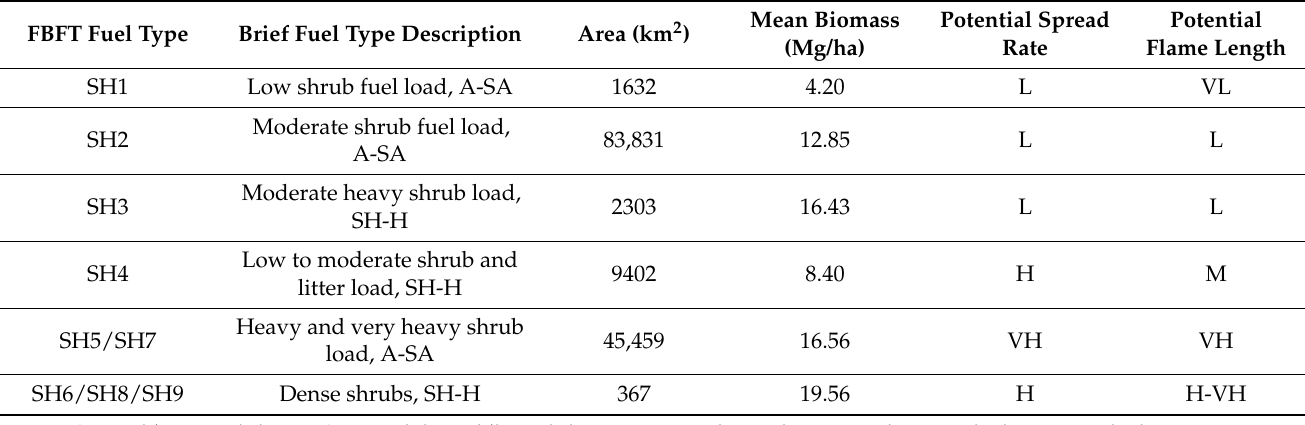
Table 3. Characterization and parameterization of the FBFT-adapted shrub fuel types. The values refer to mean fuel conditions and serve to predict fire behaviour inside and outside the fire season.